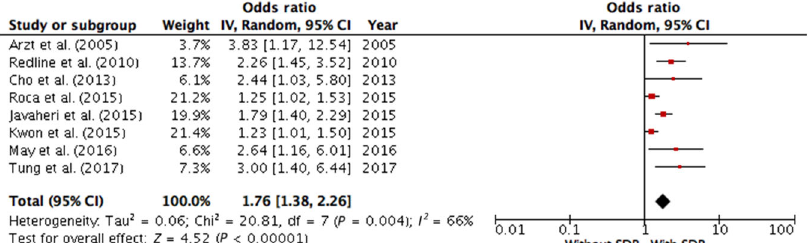
Fig. 3 Meta-analysis of association between sleep-disordered breathing and risk of cardiovascular disease (odds ratios) in an unselected general population. Arzt et al. (2005) AHI cut-off 20, outcome — incident stroke; Redline et al. (2010) AHI cut-off 15, outcome — incident stroke; Cho et al. (2013) AHI cut-off 15, outcome — cerebral infarction; Roca et al. (2015): AHI cut-off 15, outcome — all-cause mortality; Javaheri et al. (2015) CAI cut-off 5, outcome — incident heart failure; Kwon et al. (2015) AHI cut-off 15, outcome — incident atrial fi brillation; May et al. (2016) AHI cut-off 15, outcome — incident atrial fi brillation; Tung et al. (2017) CAI cut-off 5, outcome — incident atrial fi brillation. AHI apnea-hypopnea index, CAI central apnea index, CI con fi dence interval, IV inversed variance, SDB sleep-disordered